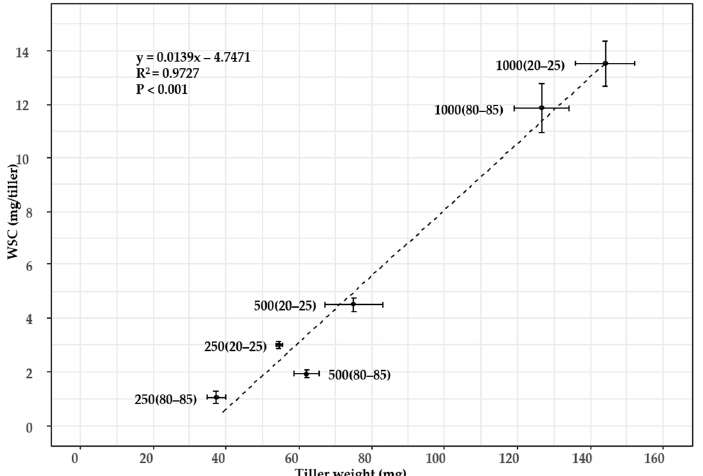
dition, tiller weight showed the same trend as WSC, increasing with a decrease in defoli- ation frequency, and with water restriction. However, plants defoliated at the low fre- quency did not exhibit WSC differences between both water treatments (Figure 1).